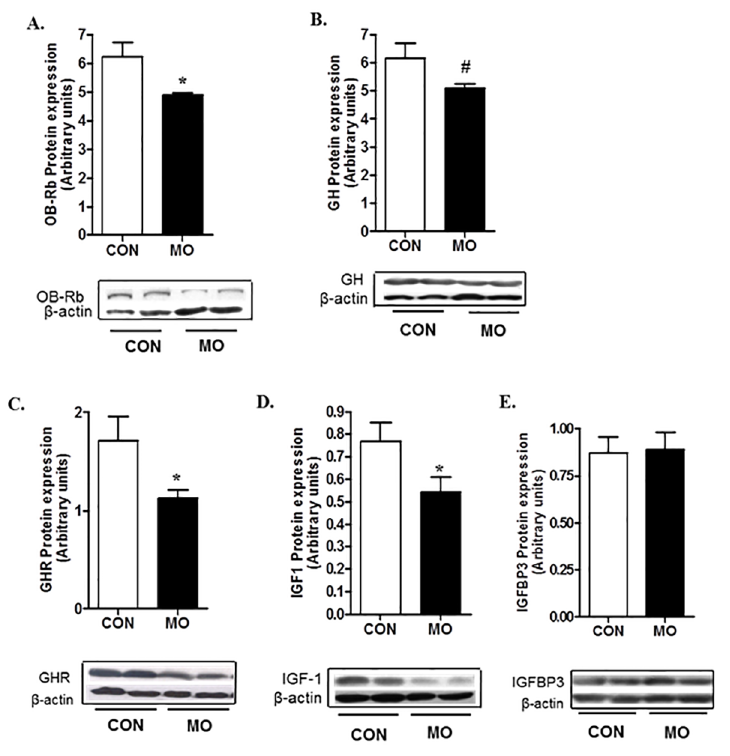
Fig 5. Protein expressionof OB-Rb (A), and GH (B) in pituitary, and GHR (C), IGF1 (D), and IGFBP3 (E) in liver samples of CON (open bars, n = 6) and MO (solid bars; n = 6) adult male F1 offspring. * Means ± SEM differ, ( P < 0.05). # Means ± SEM tended to differ, ( P < 0. 10).